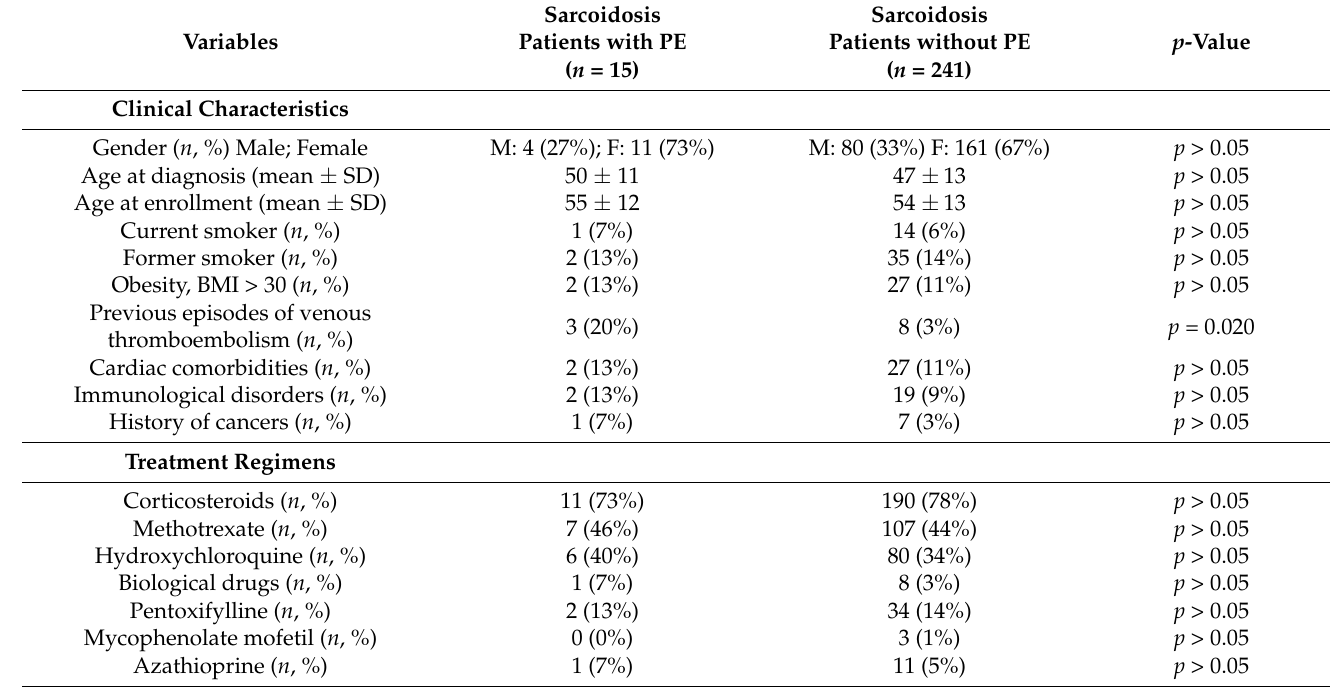
Table 1. Clinical characteristics of the study population at